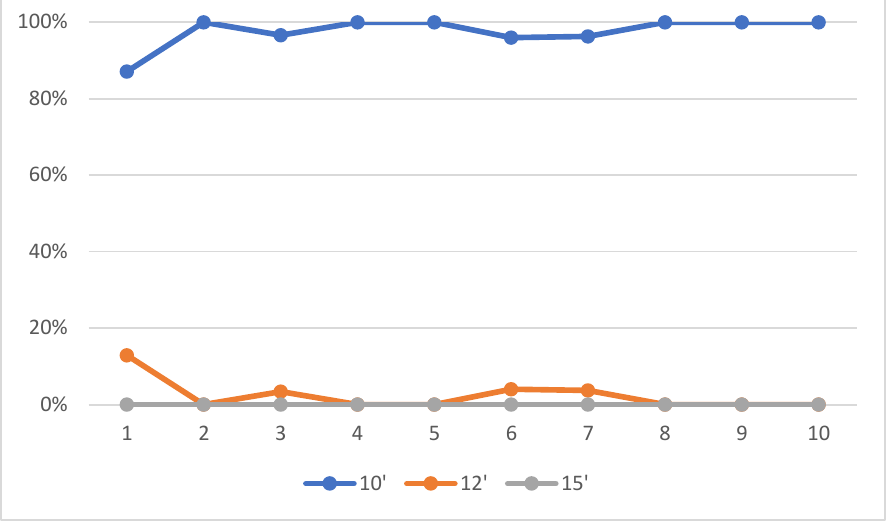
Figure 3. The distribution of selected run times in Test Group 2. Table 3. The percentage-based distribution of the selected times. A close correlation was discerned between the groups and the distances covered. In Test group 1, better results were achieved regarding the distances in all ten runs. Test group 2 did not post any outstanding results to be measured, as they covered shorter distances due to the selected shorter duration. In light of the selected duration, it can be concluded that in the case of choosing longer running times, greater distances were covered (Table